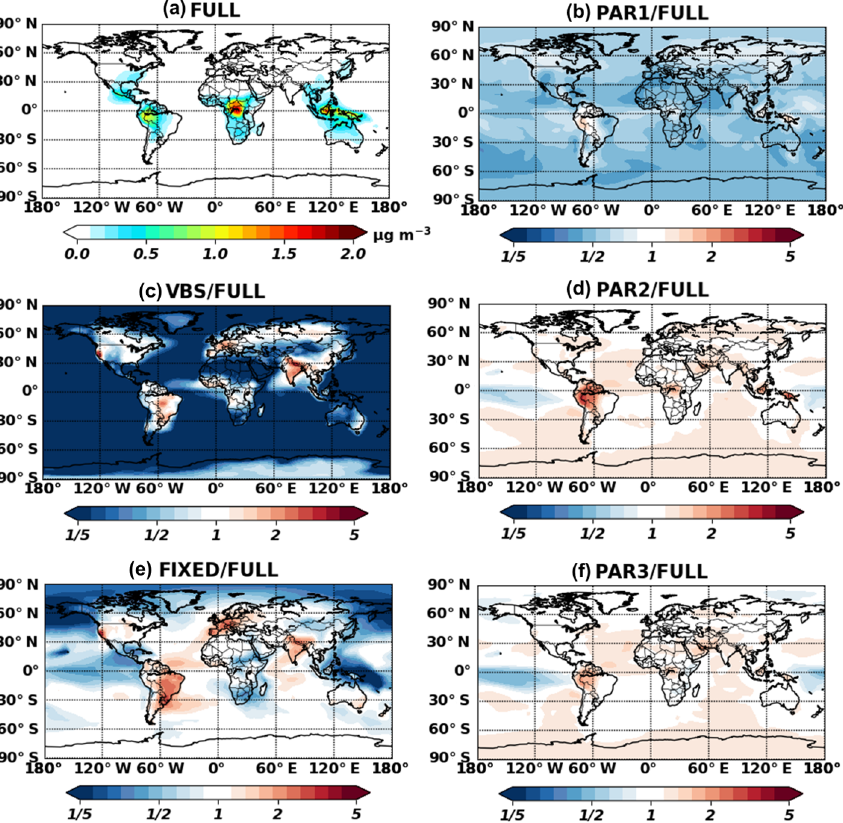
Figure 3. Annual mean (July 2013–June 2014) surface concentrations for IEPOX-SOA as predicted by full chemistry (a) . Ratios of parame- terized IEPOX-SOA concentrations to the full chemistry case are shown in panels (b) – (f)